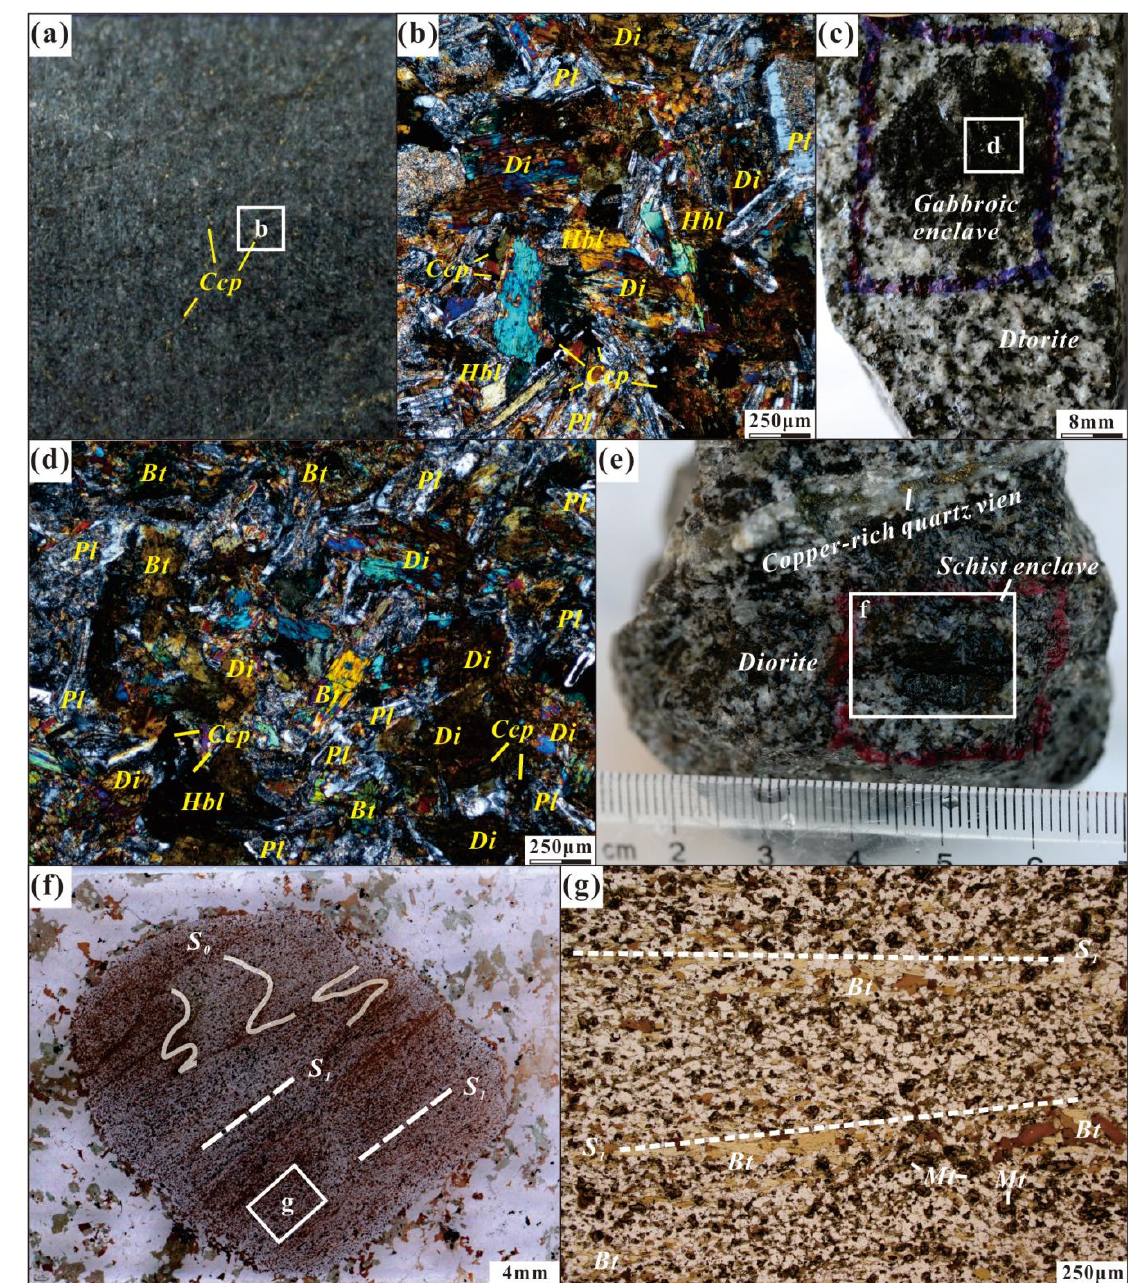
Figure 3. Representative photographs of the gabbroic enclave and schist enclave within diorite. Hand specimen of the bulky gabbroic enclave ( a ); photomicrograph of the bulky gabbroic enclave ( b ); hand specimen of diorite with a smaller gabbroic enclave ( c ); photomicrograph of the smaller gabbroic enclave ( d ); diorite specimen containing a schist enclave ( e ); scanning image showing the outer morphology and inner deformation of the schist enclave ( f ); a parallel light microphotography of the deformed schist enclave ( g ). The white line in panel f represents the bedding structure (S 0 ), and the white dashed line in panels f and g represent foliations (S1) displayed by oriented quartz and biotite crystals. Abbreviation: Bt: biotite; Ccp: chalcopyrite; Di: diopside; Hbl: hornblende; Mt: magnetite; Pl: plagioclase.